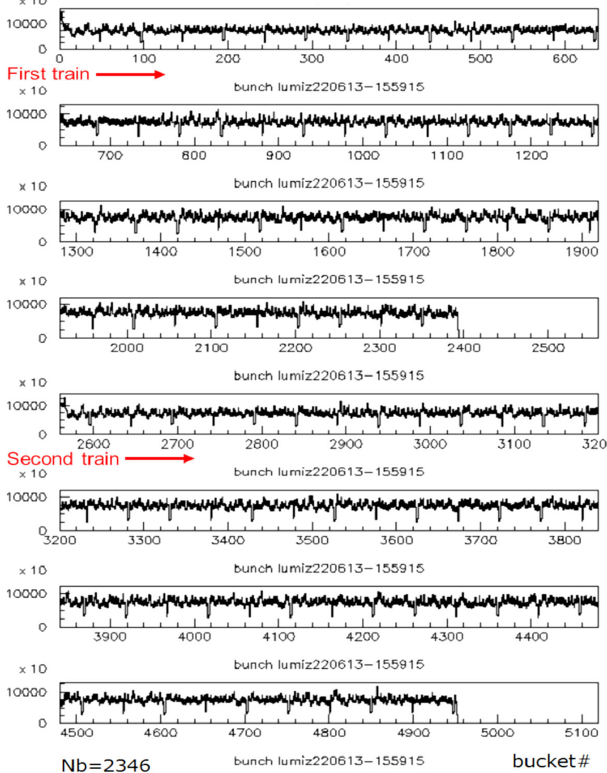
FIG. 22. Bunch-by-bunch luminosity for a bunch filling pattern of 2/1173/2.04rf on the 13th of June 2022. The vertical axis shows the number of hits at each ZDLM